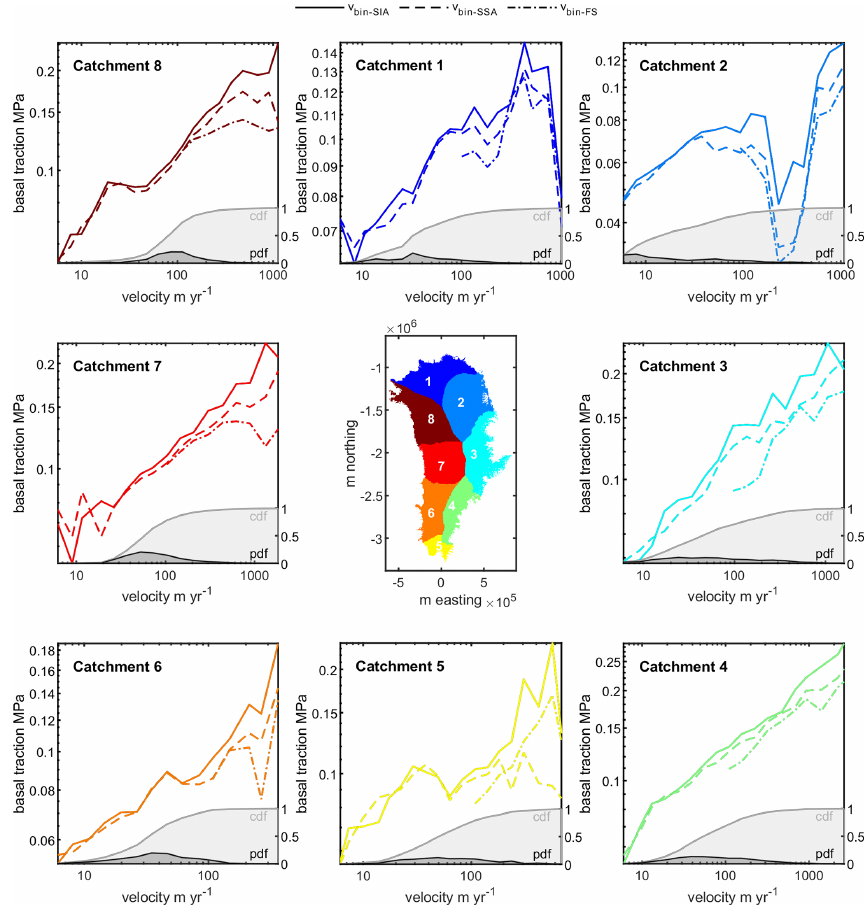
Figure 5. The relationships between velocity and traction for the SIA (solid line), SSA (dashed line), and FS (dash-dotted line) are shown together for each catchment. The right axis shows the probability density function (black line) and cumulative distribution function of the data (grey line) moving through the velocity